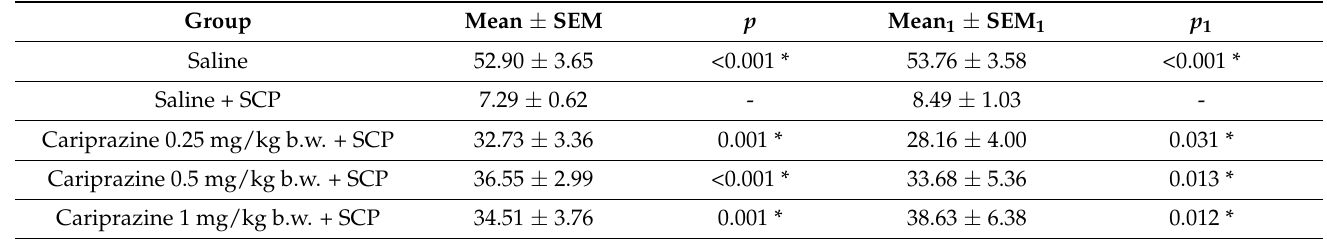
Table 1. Training latency values (in seconds) in step-down passive avoidance test.